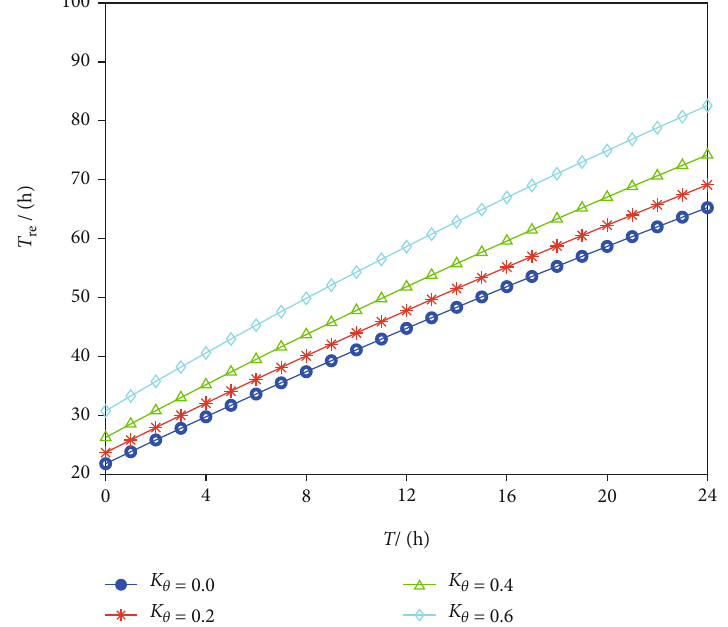
Figure 7: Abort return time versus the abort time of the single-impulse abort orbit under di ff erent fl ight-path angle